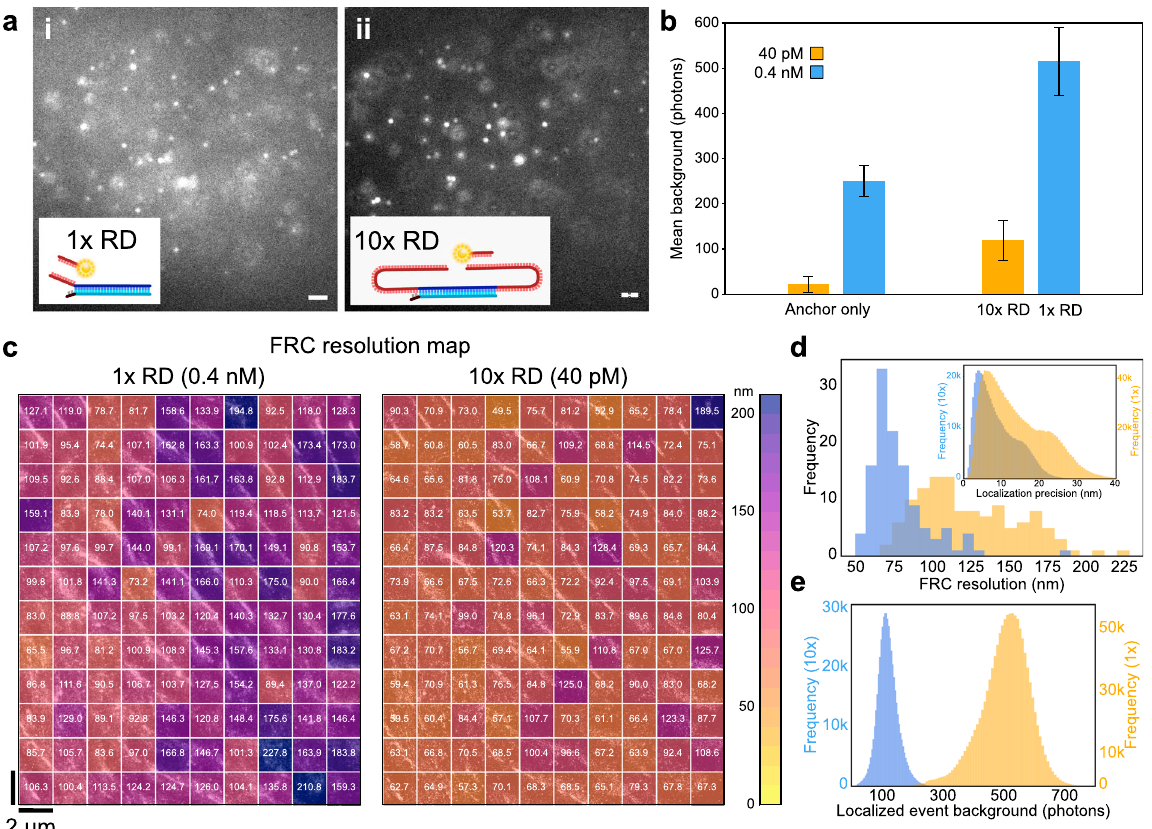
Fig. 2 Repeat DNA-PAINT allows reducing backgrounds and increases image resolution. a Raw camera frames of cardiac tissue labeled for RyRs and recorded using 1x RD with [ I ] = 0.4 nM ( i ), and then 10x RD with [ I ] = 40 pM (ii), using the scheme in Fig.1c. Note the lower background and better contrast in ii. Similar levels observed in n = 5 repetitions in biological tissue. b Background increases approximately proportionally with imager concentrations in tissue containing only anchor strands (n = 712 events for [ I ] = 40 pM, 5002 events for [ I ] = 0.4 nM), i.e. without complementary binding sites. Once functionalized with 1x RD ( n = 683k events) or 10x RD ( n = 537k events), out-of-focus binding events contribute to an additional offset. P1 imager concentration 40 pM (orange) and 0.4 nM (blue). Event frequencies were similar in both modalities (1x – 10x RD) with an order of magnitude difference in imager concentration, comparable to other biological experiments (Supplementary Fig. 2). Error bars are SD around the mean. c Fourier Ring Correlation resolution maps, displaying the resolution in nm per segment, calculated for 1x RD and 10x RD imaging runs of the same region in a thick (20 µ m) tissue section labeled for alpha actinin, see also Supplementary Fig. 3. d The improvement in FRC resolution, taken explicitly from the FRC